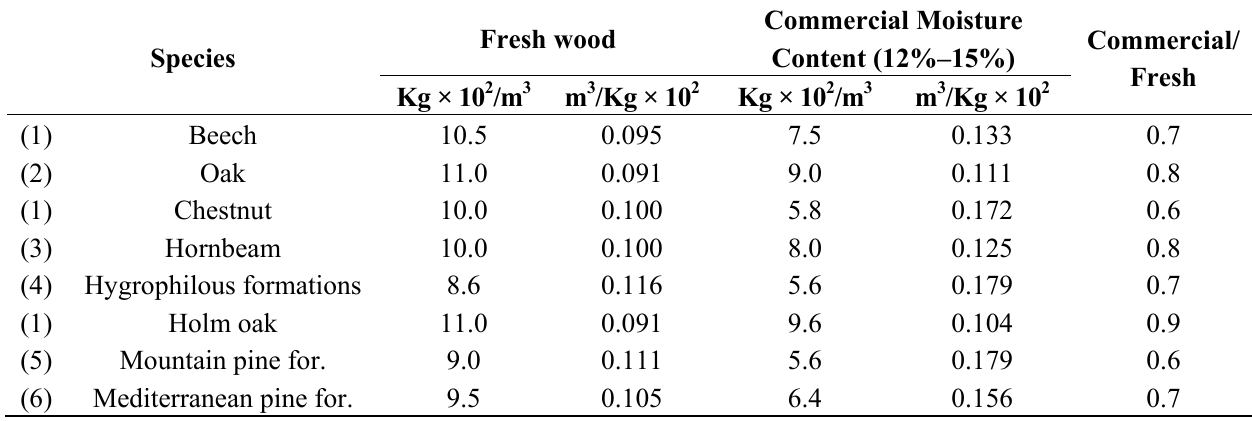
Table 4. Density of different types of woods in Basilicata. Source: [39].